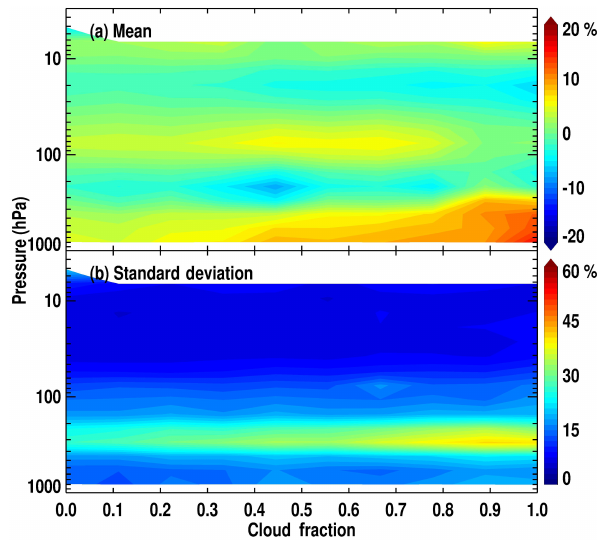
Figure 6. Same as Fig. 5 but as a function of cloud